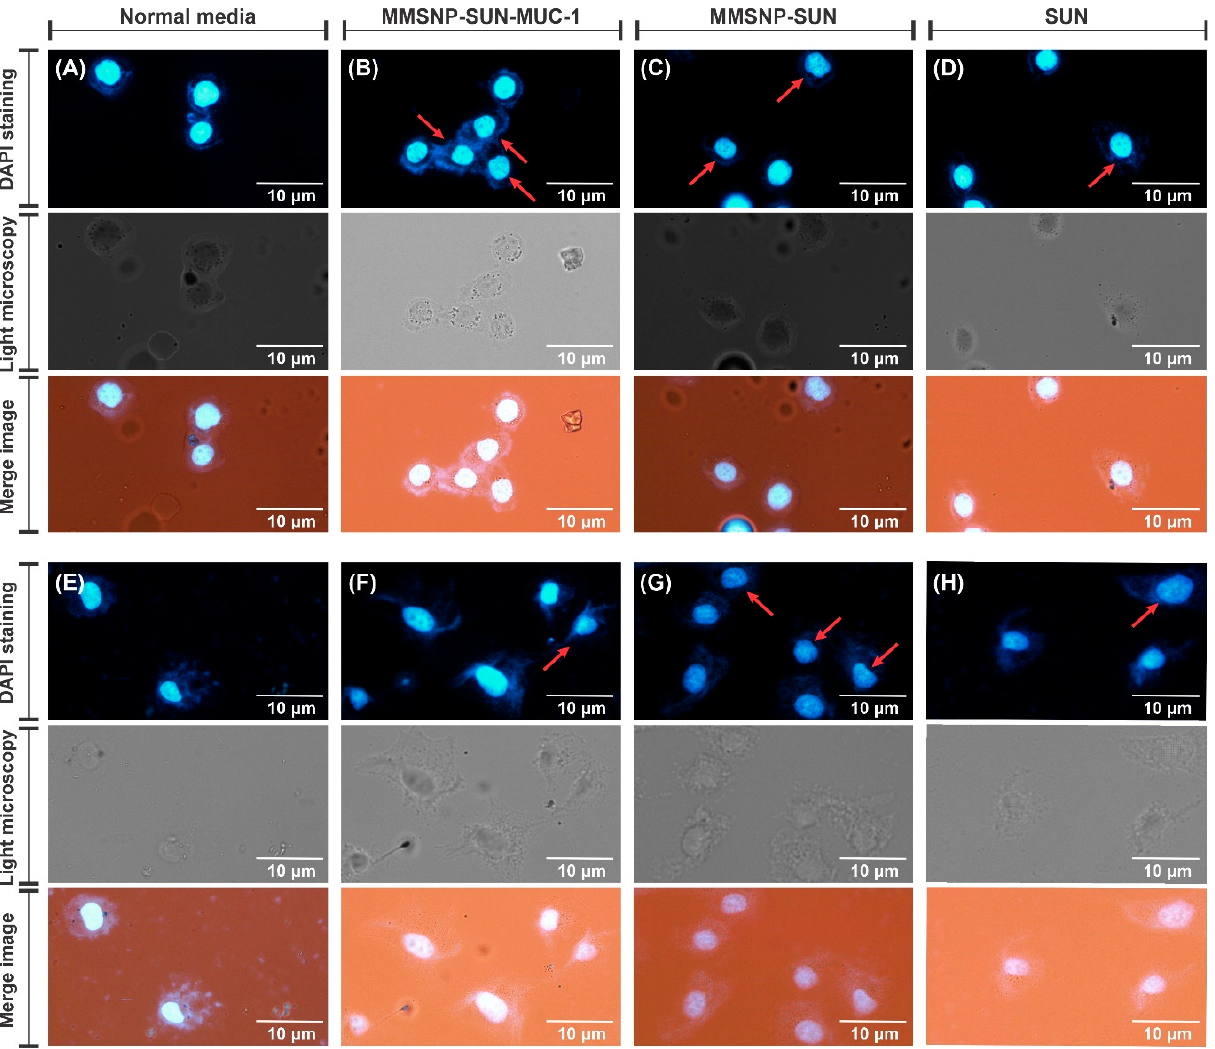
Figure 6. The nuclear morphological change analysis (DAPI staining image, light microscopy, merge images) of OVCAR-3 cells and MDA-MB-231 cells, respectively after exposure to normal media ( A , E ), MMSNP-SUN-MUC-1 ( B , F ), MSNP-SUN ( C , G ) and SUN ( D , H ).